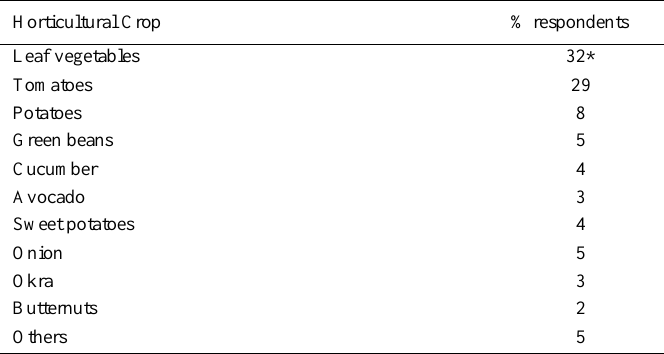
Table 2. Results* of the horticultural crops that were ready for the market as from April 7 to May 7, 2020 during the lockdown period (n=300). Horticultural Crop %